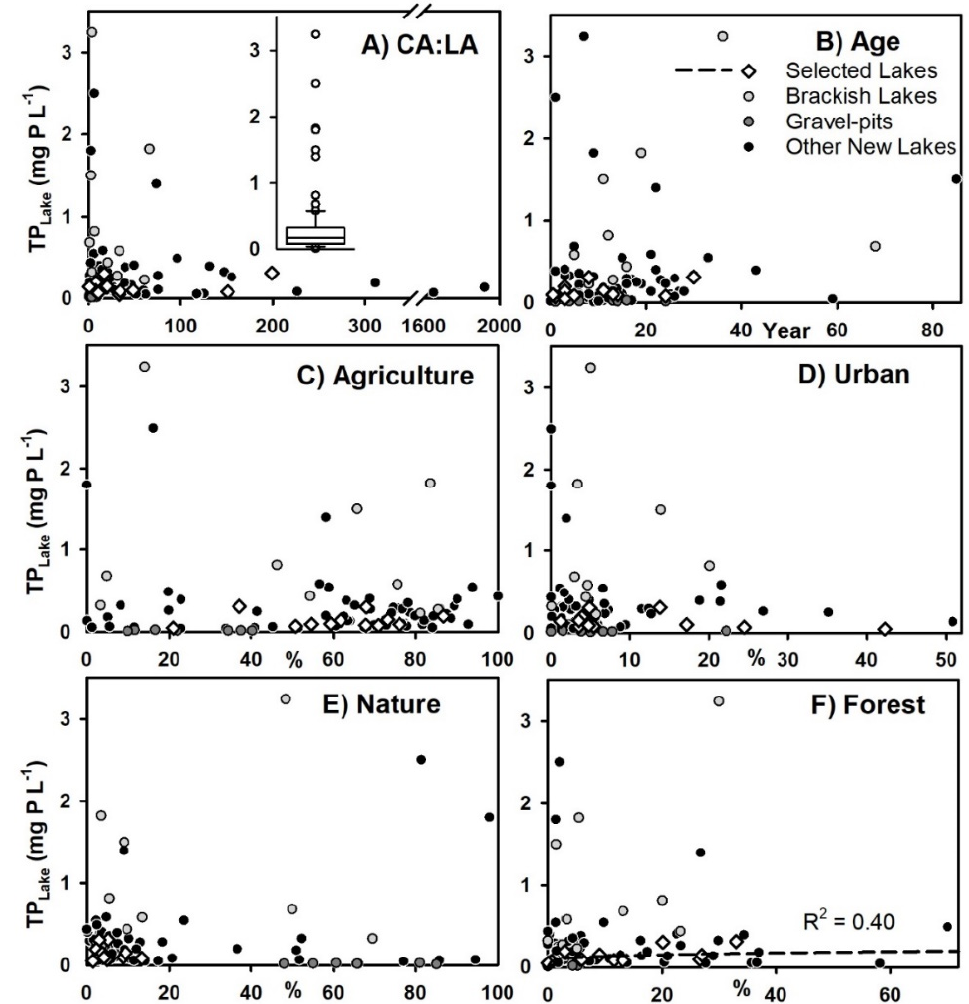
Figure 3. TP Summer of the 12 selected new lakes ( n = 12) and additional new lakes ( n = 78), of which ( n = 10) were impacted by seawater (brackish lakes), and ( n = 7) were lakes formed from mineral excavation (gravel-pits). ( A ) TP Summer as a function of the ratio between catchment area and lake area, CA:LA with a boxplot of TP Summer included. ( B ) TP Summer as a function of the age of the lakes at the time of sampling. ( C ) TP Summer is a function of the proportion of the catchment constituted by agriculture, ( D ) urban ( E ) nature, and ( F ) forest catchments. Significant relationships are shown, and the R 2 -values stated; all regressions can be found in Supplementary Materials.